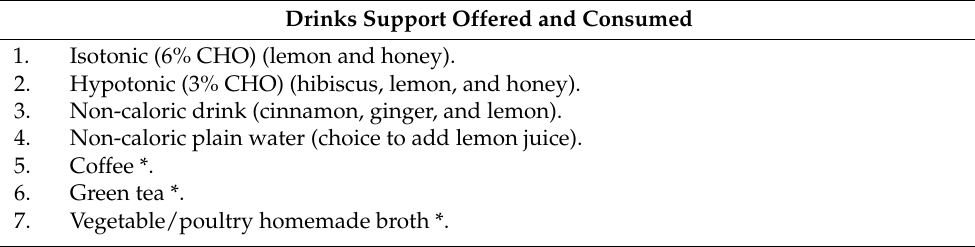
Table 2. Type of drinks offered during the event day.